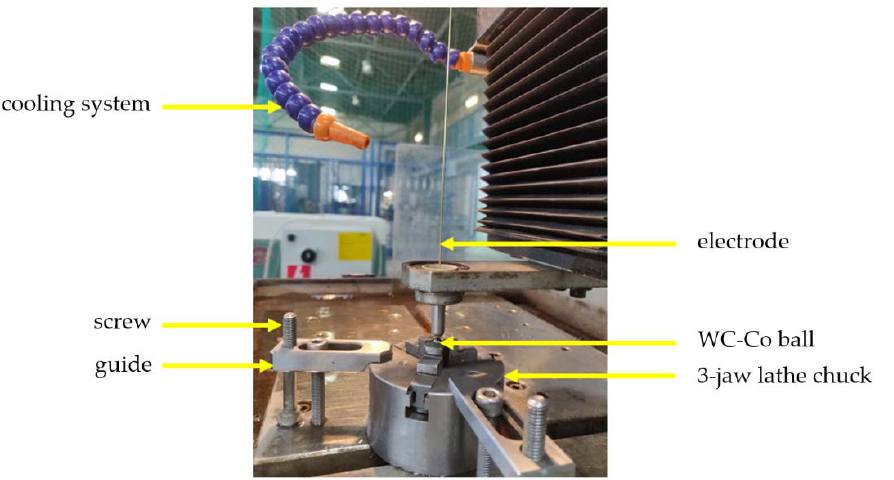
Figure 3. The EDM machining process of 5 mm deep blind holes (Ø1 mm) in Ø6 mm WC-Co balls.